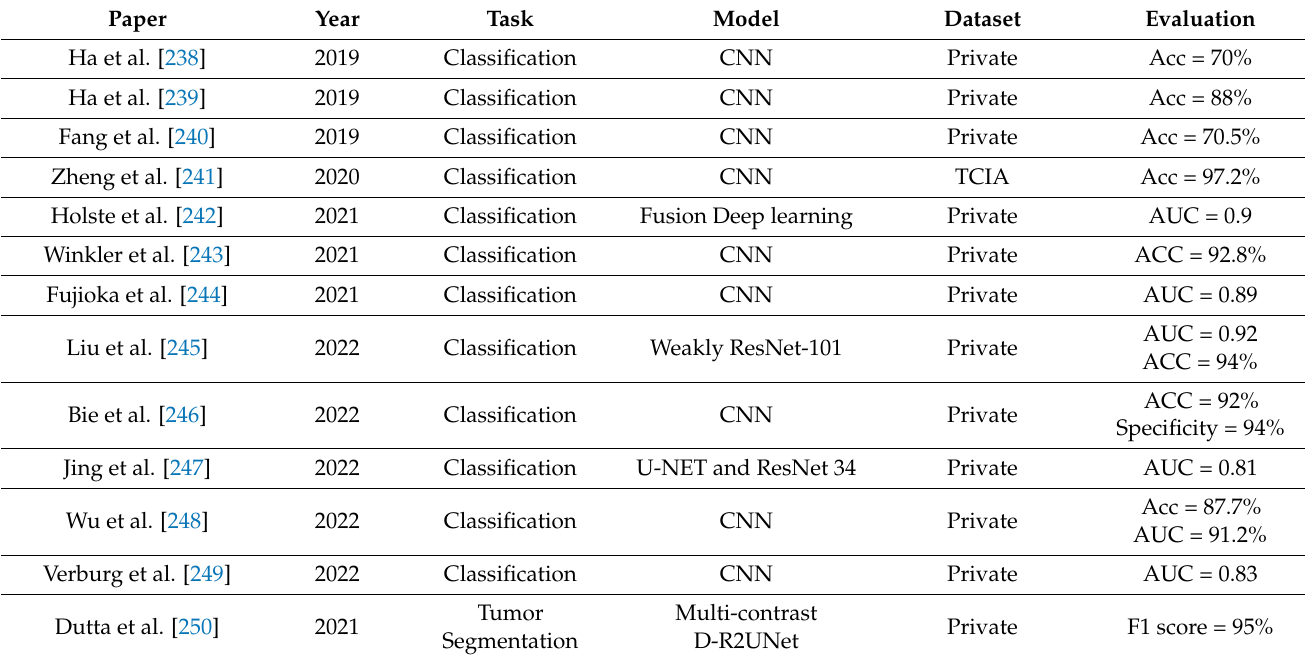
Table 5. Summary of the studies that used MRI